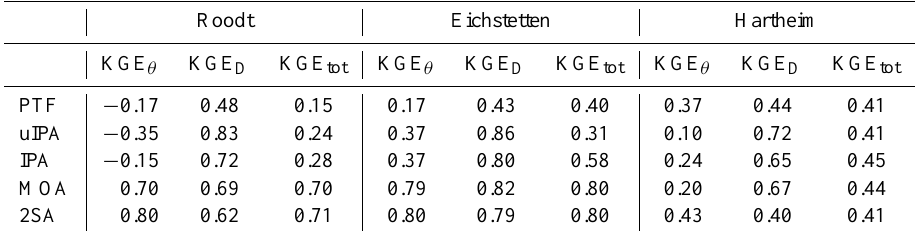
Table 3. Performance of the pedotransfer functions (PTF) and the different inverse model approaches (uIPA, IPA, MOA, 2SA) regarding the soil moisture (KGE θ ) and isotope (KGE D ) data and the average of both the efficiency measure (KGE tot ) for the three study sites. (Perfect fit would result in a Kling–Gupta efficiency (KGE) of 1.)